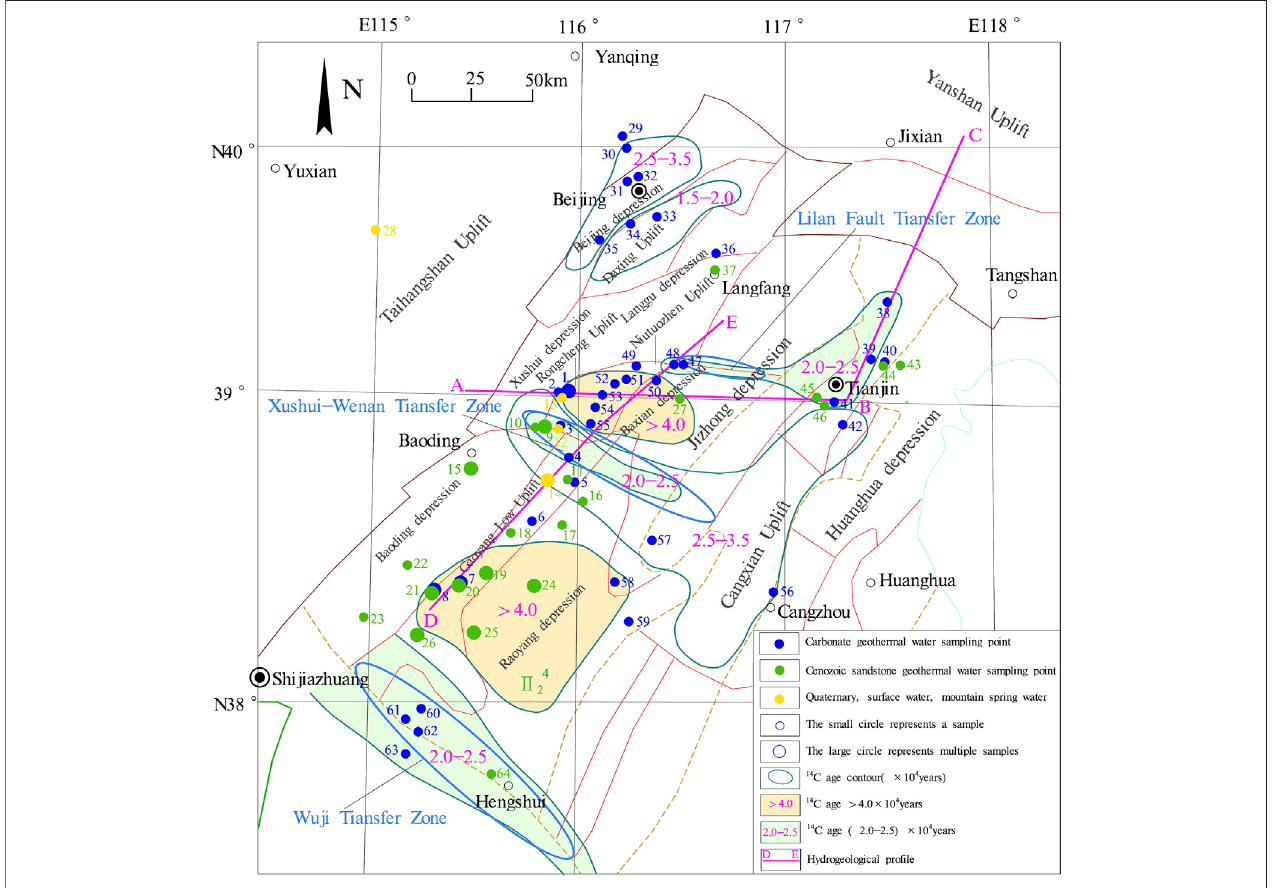
FIGURE 2 | Samples of geothermal water isotopes and isotope dating contours of carbonate geothermal water in the study area.